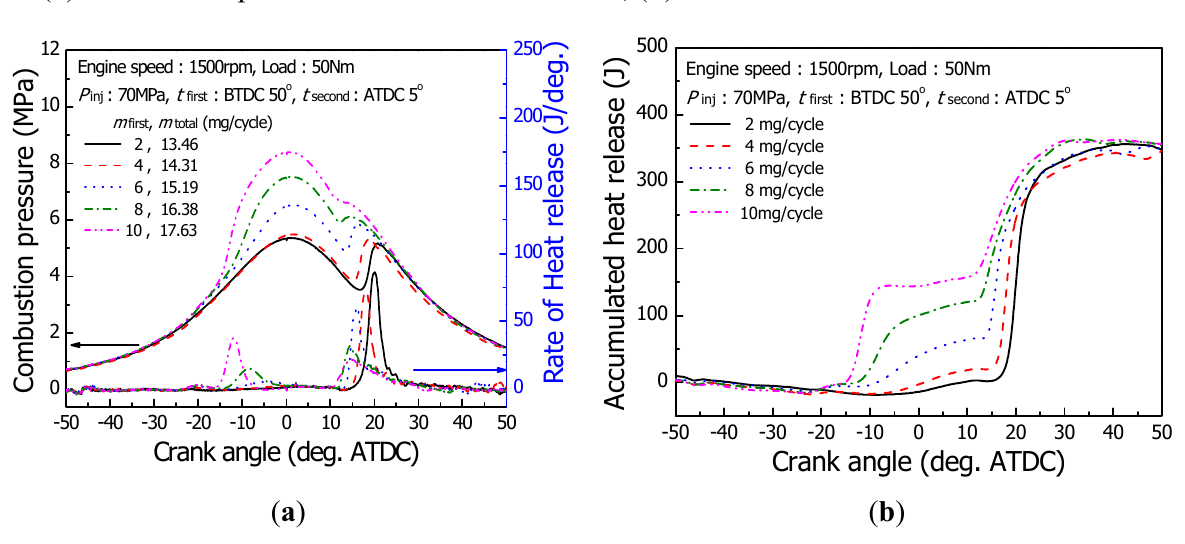
Figure 2. Combustion characteristics variable first injection quantity of two stage injection: ( a ) Combustion pressure and rate of heat release; ( b ) Accumulated heat